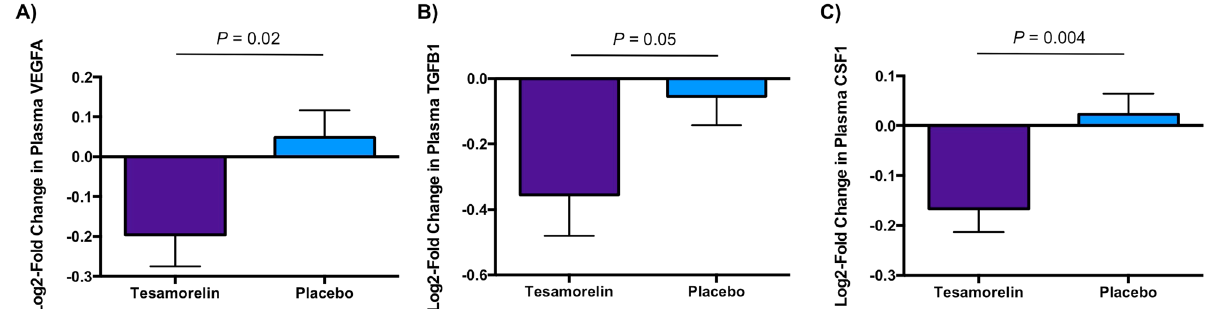
Figure 2. Differential Changes in Plasma VEGFA, TGFB1, and CSF1 by Treatment Status. Tesamorelin led to significant reductions in plasma (A) VEGFA (log 2 -fold change, mean ± SD, − 0.20 ± 0.35 vs. 0.05 ± 0.34, P = 0.02), (B) TGFB1 (log 2 -fold change − 0.35 ± 0.56 vs. − 0.05 ± 0.43, P = 0.05), and (C) CSF1 (log 2 -fold change − 0.17 ± 0.21 vs. 0.02 ± 0.20, P = 0.004) compared to placebo. Bars and error bars indicate mean and standard error of the mean, respectively. Abbreviations: CSF1, macrophage colony stimulating factor 1; TGFB1, transforming growth factor beta 1; VEGFA, vascular endothelial growth factor